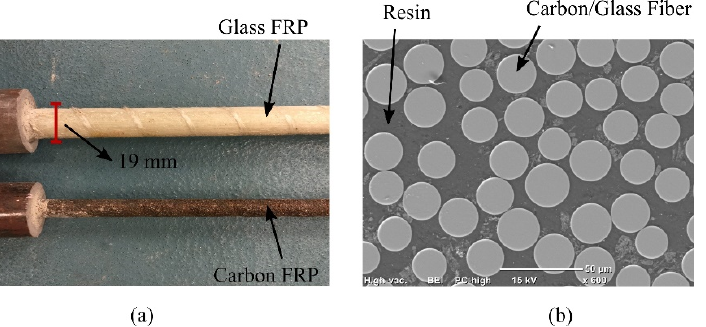
Figure 3. ( a ) Morphology of fiber reinforced polymer bars ( b ) Scanning electron microscope (SEM) image of fiber reinforced polymer bar.